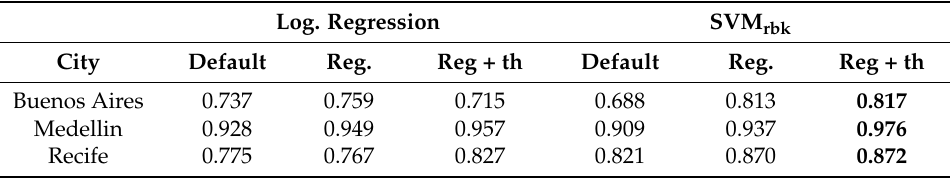
Figure 7. Time (s) taken by each method to classify a fishnet cell. Table 6. Tuning the best classification models ( F2 -scores).